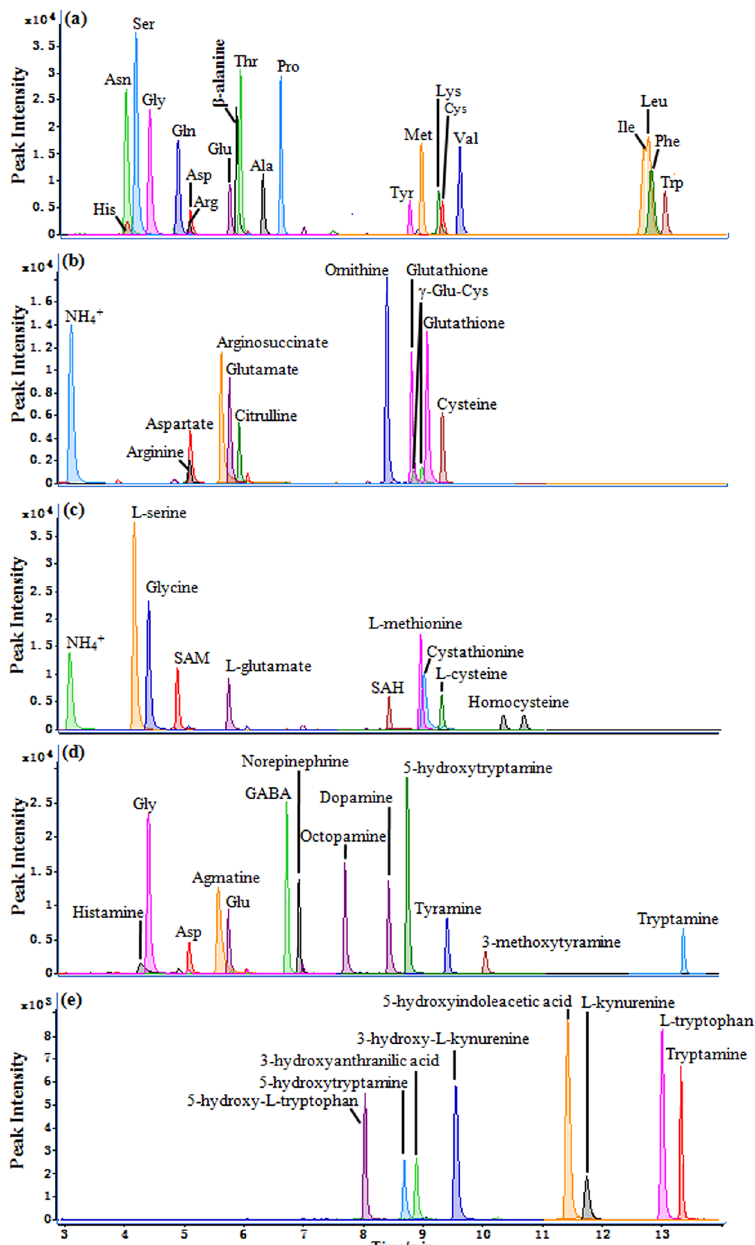
Figure 5. UHPLC-MS/MS chromatograms for the 5-AIQC-tagged amino metabolites in multiple metabolic pathways including ( a ) protein biosynthesis/degradation, ( b ) urea cycle, ( c ) folate-associated homocysteine metabolism, ( d ) biosynthesis of monoamine neurotransmitters and ( e ) tryptophan-mediated kynurenine